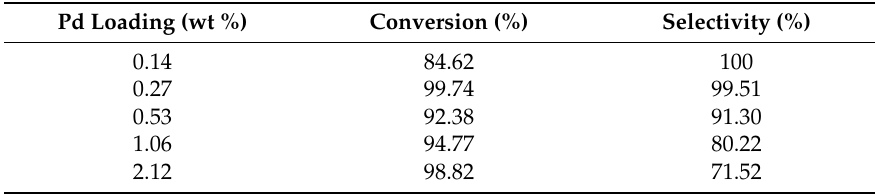
Table 2. Catalytic properties of catalyst with different Pd loading.